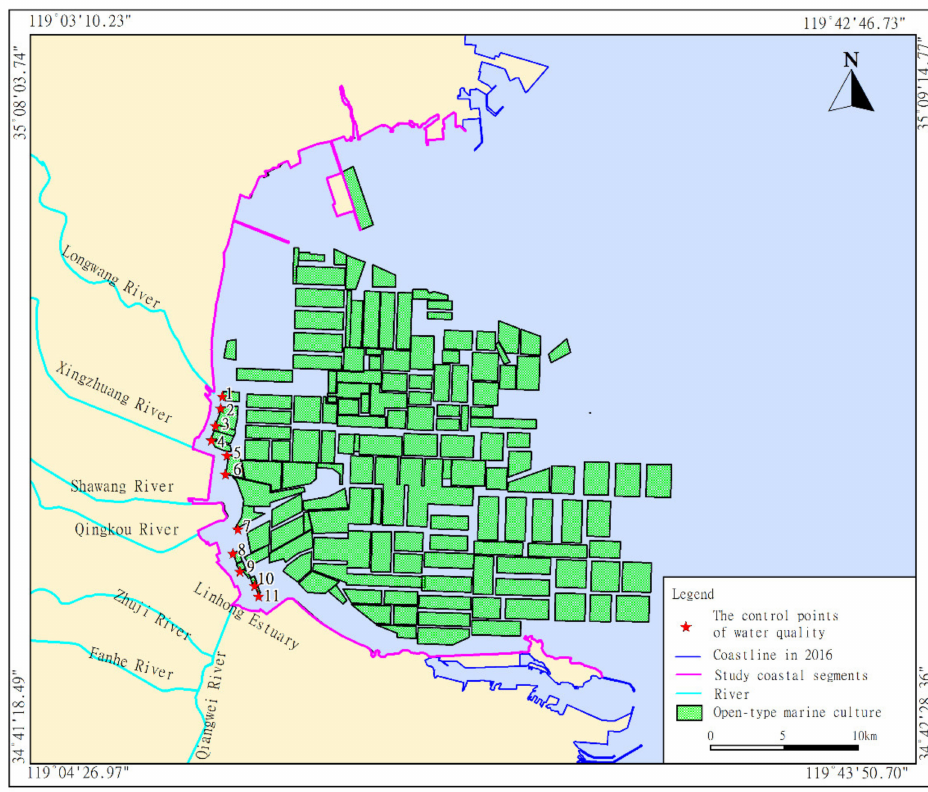
Figure 9. The control points of water